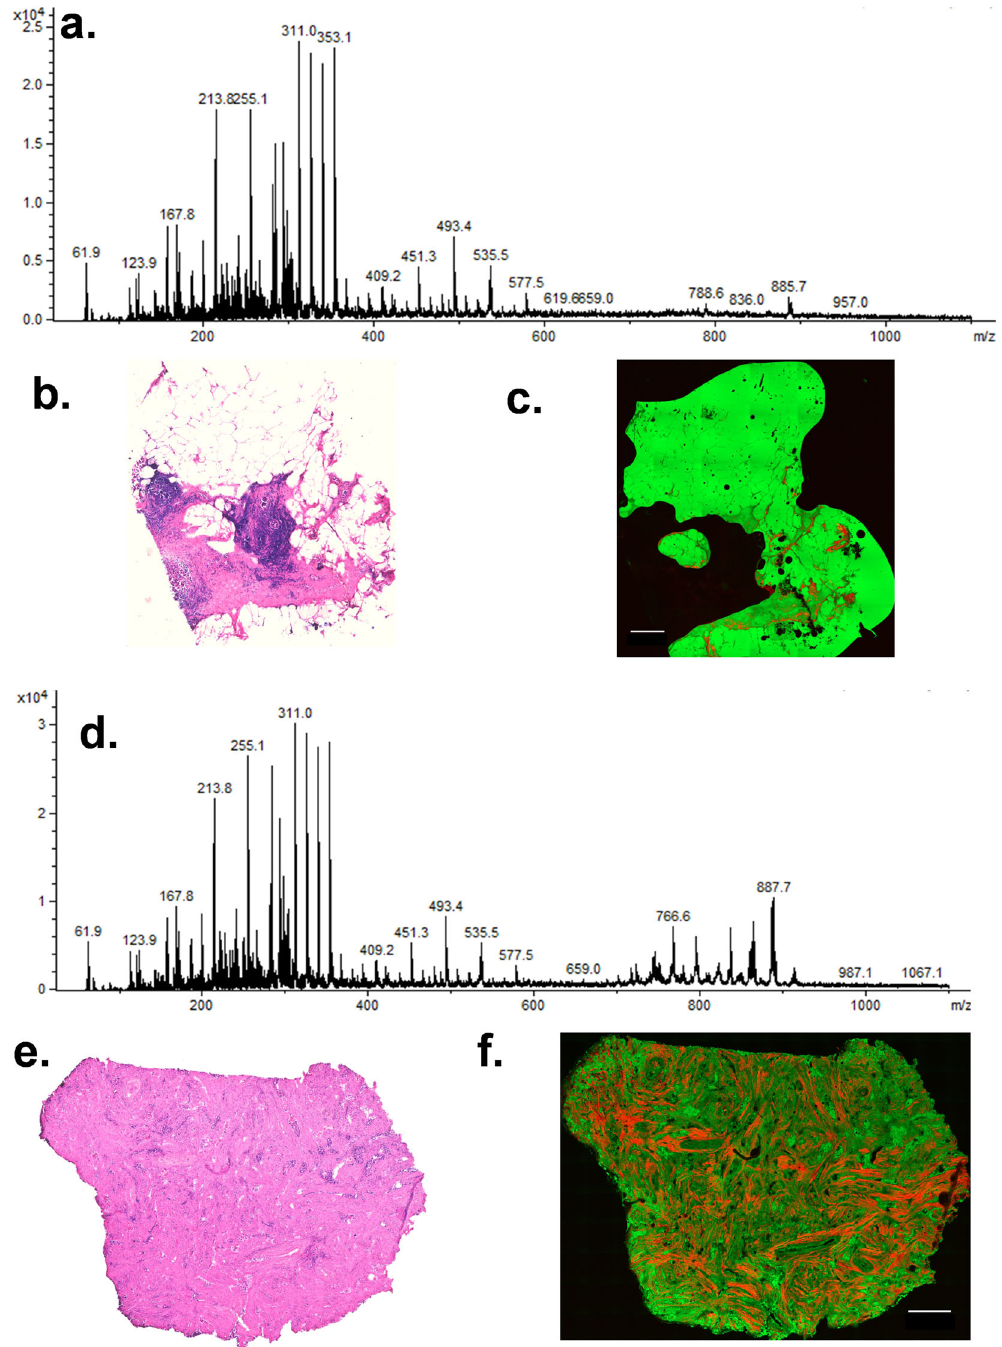
Fig. 2 Mass spectra, histological and stimulated Raman scattering microscopy of normal and tumor tissue (case 13). a Intraoperative mass spectrum generated from normal (benign) breast tissue. b H&E stain of normal tissue. c SRS image of sister section. d Intraoperative mass spectrum generated from tumor tissue. The scale bar is 250 µm. e H&E stain of tumor tissue. f SRS image of the parallel section. In SRS image, areas of green correlate with lipids, while orange correlates with collagen. The scale bar is 500 µm. assessing margins without measurement of the corresponding clinical care, our approved protocol allowed us to collect six tumor samples is currently ongoing. Moreover, it is important to margin specimens from each sample, but tumor tissue only when note that the dimensions of each of the surgical margin the tumor measured at least 1.5 cm in the greatest dimension. specimens that we sampled from the lumpectomy specimen Consequently, only about half of the specimens in our study had represent only a small portion of the total surface present at the suf fi cient tumor present to permit the analysis of tissue directly specimen margins, signi fi cantly reducing the likelihood of from the tumor mass. Without both normal and tumor tissue from detecting positive margins should tumor be present. Despite this the same specimen, the interpretation of mass spectra from potential limitation, the endpoint analysis for our studies is to margin samples can be challenging. Method development for Published in partnership with the Breast Cancer Research